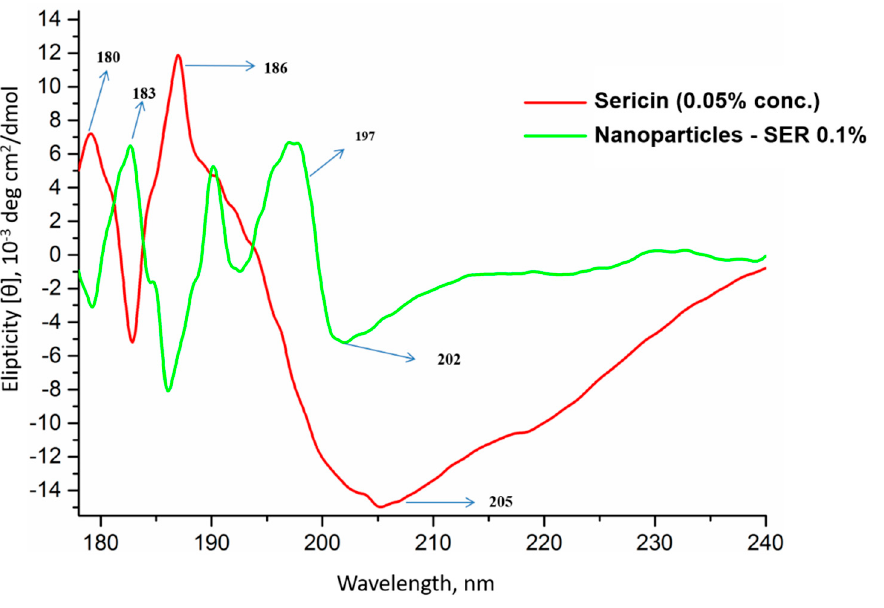
Figure 9. CD curves of native sericin (0.05 wt.% concentration) and sericin nanoparticles (SER-0.1%) .